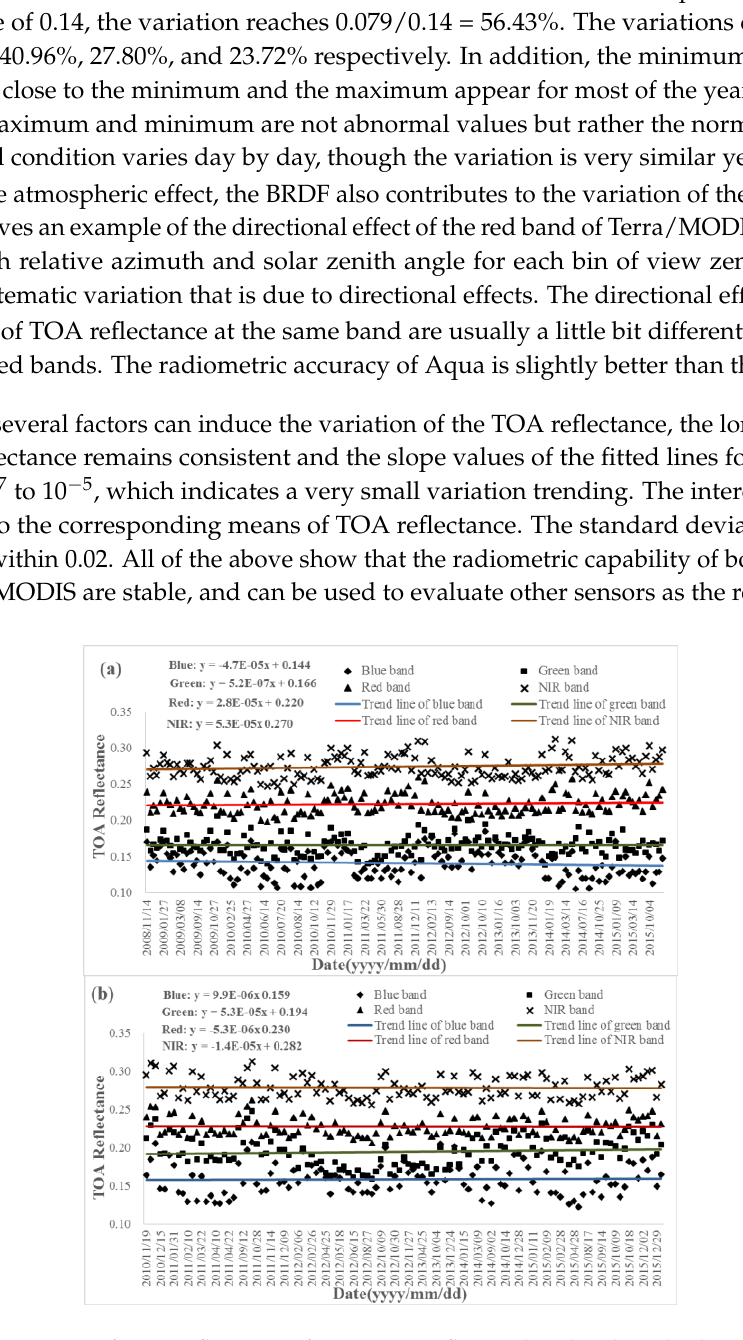
Figure 6. Time series of TOA reflectance of MODIS in reflective bands. The color lines are the trend lines of the bands. ( a ) Terra/MODIS; ( b ) Aqua/MODIS.